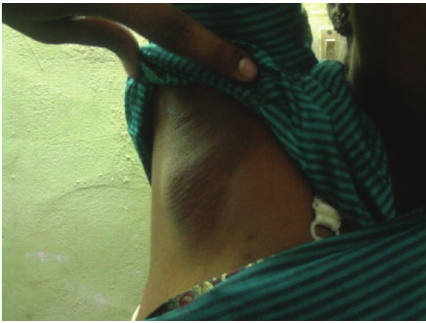
Figure 1: Clinical picture showing the swelling in the axilla.